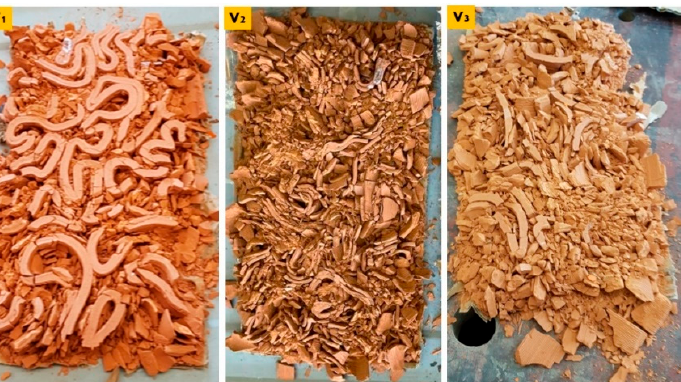
Figure 12. Exhibits comparison between the cumulus of three linear model bricks, V1, V2, and V3, post-collapsing as a result of the compression test. It can be observed that the V1 exhibited the highest resistance since it maintained many of its parts, followed by the V3. At the same time, the V2 recorded the least compression resistance as it was the most affected, as shown in the figure.